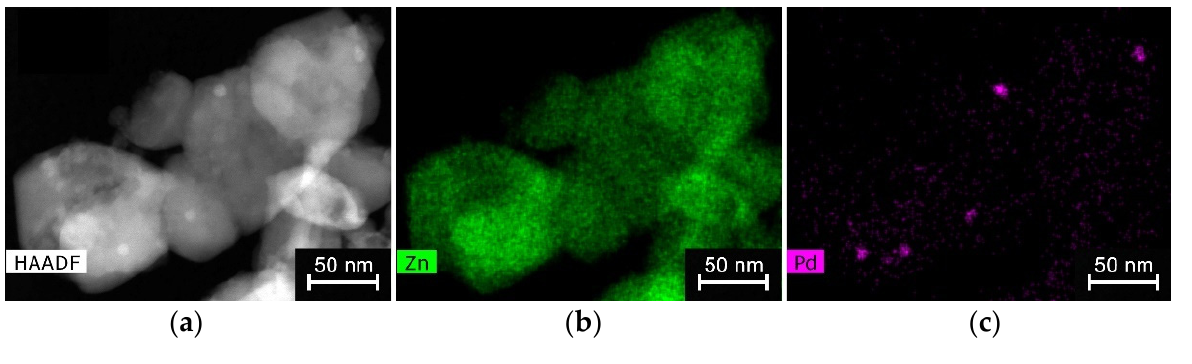
Figure 1. SEM images of ZnO nanofibers at different magnifications : ( a ) 10,000× and ( b ) 100,000×.